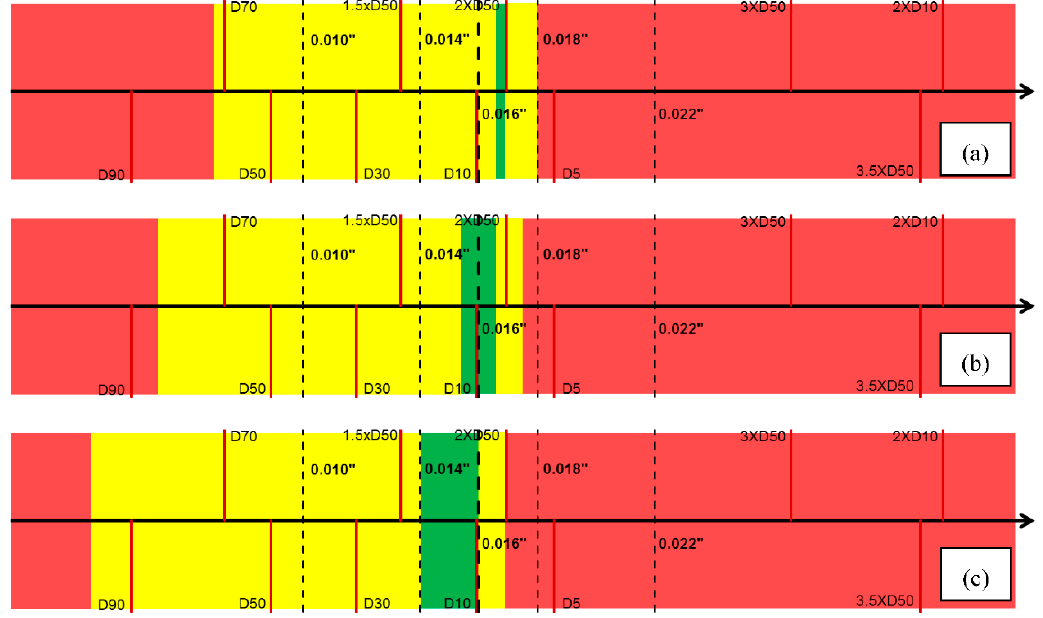
Figure 16. TLS of DC ‐ III in the aggressive condition for SPF 120 ( a ), SPF 168 ( b ), and SPF 216 ( c ).